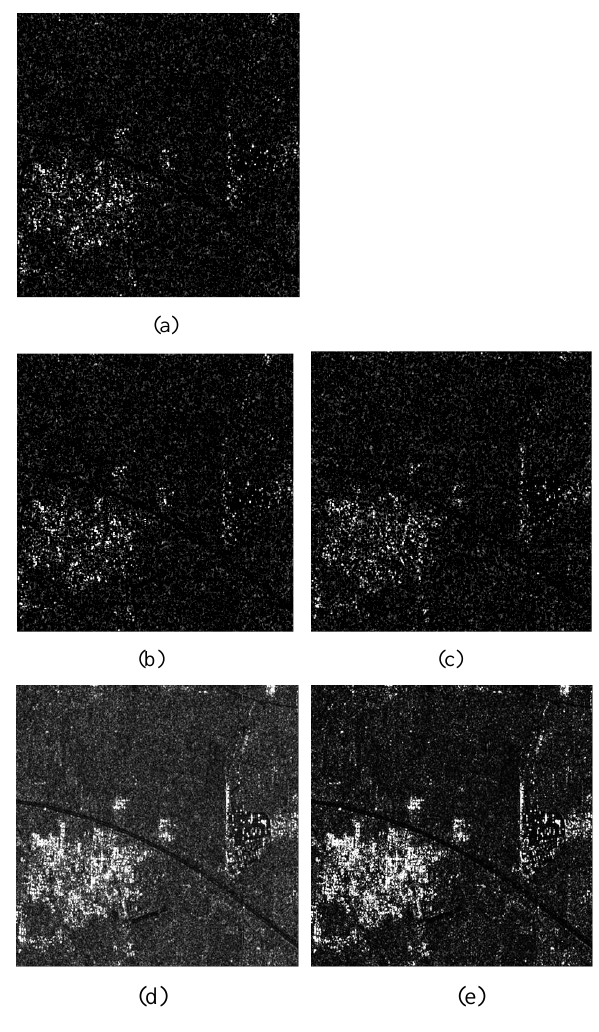
Fig 2. GF-3 SAR image: (a) Amplitude image (b) Intensity